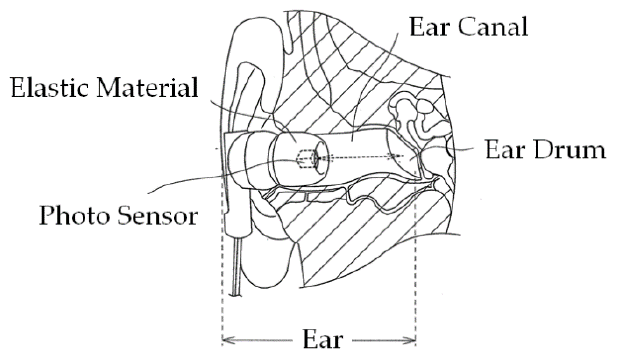
Figure 2. Principle of ear canal movement measurement using ear sensor. Occlusion is performed by the temporalis and masticatory muscles, including the masseter muscle and the temporomandibular joint. Occlusion causes a change in the ear canal shape near the masticatory muscles and the temporomandibular joint. The ear sensor measures this shape change in the ear canal during occlusion optically and noninvasively. A small photosensor is attached to the ear sensor. This photosensor houses a light-emitting diode (LED) with an emission wavelength of 940 nm and a phototransistor, as illustrated in Figure 1. The ear sensor irradiates the skin of the ear canal with infrared light, and the reflected light is then received by the phototransistor to measure the change in the ear canal shape.